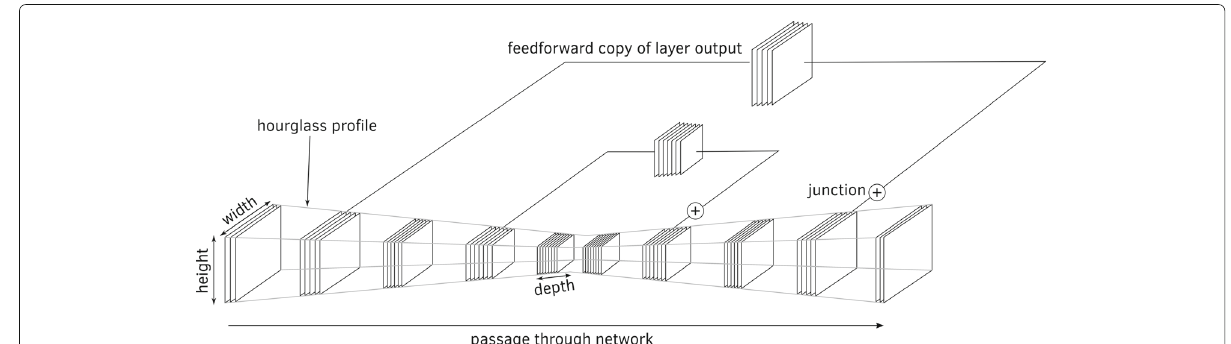
Fig. 9 Example of a stacked hourglass CNN. The stacked hourglass CNN not only follows a conventional CNN structure by reducing image width and height, and increasing depth but is also followed by an inverting structure which returns the width, height, and depth to original or near-original values